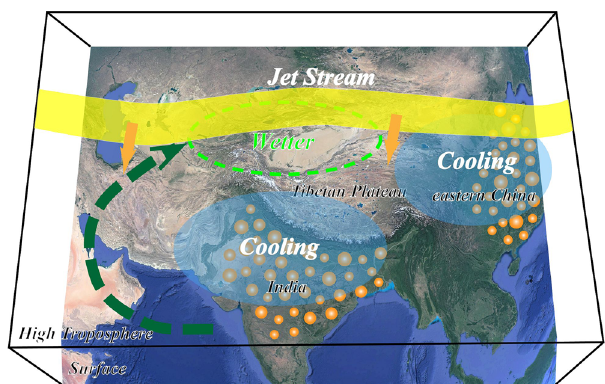
Fig. 5 Schematic illustration of teleconnection-like effect of anthropogenic aerosols in heavily polluted regions on summer precipitation increase over Arid Central Asia. The yellow belt represents the Asian Westerly Jet Stream (AWJS), and the corresponding arrows indicate the southward shift of AWJS. The dashed green arrow represents the moisture fl uxes from low latitudes through anomalous low-level southwesterly winds. Base map from Google Earth, Landsat/Copernicus (Data: SIO, NOAA, U.S. Navy, NGA, GEBCO, IBCAO,